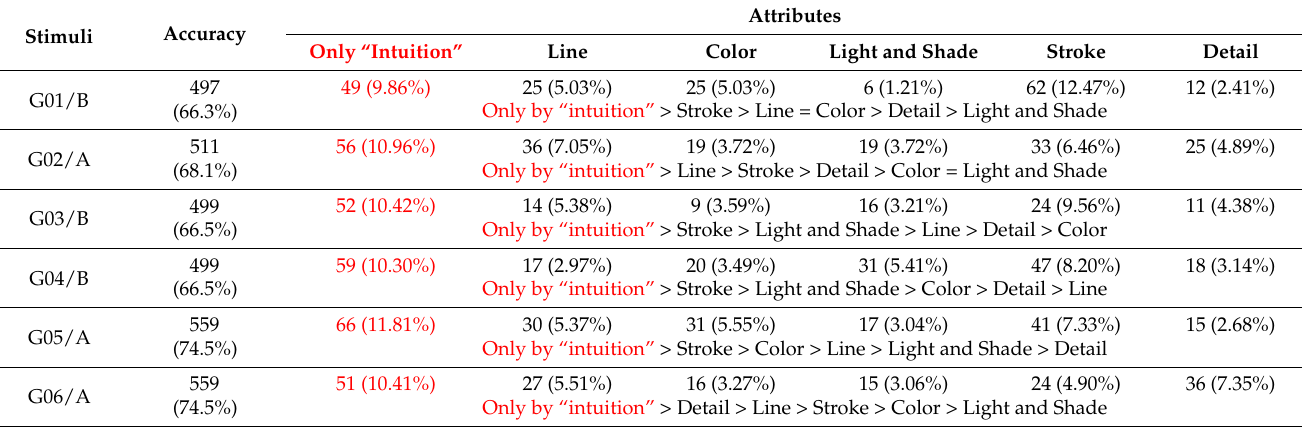
Table 10. The number of votes for the attributes selected by the